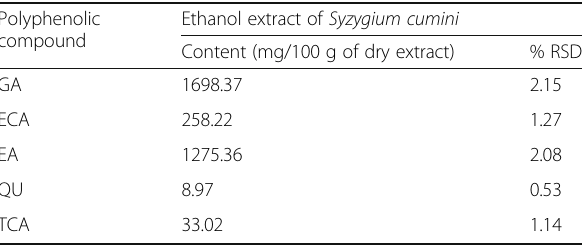
Table 2 Contents of polyphenolic compounds in the ethanol extract of Syzygium cumini ( n = 5) Polyphenolic